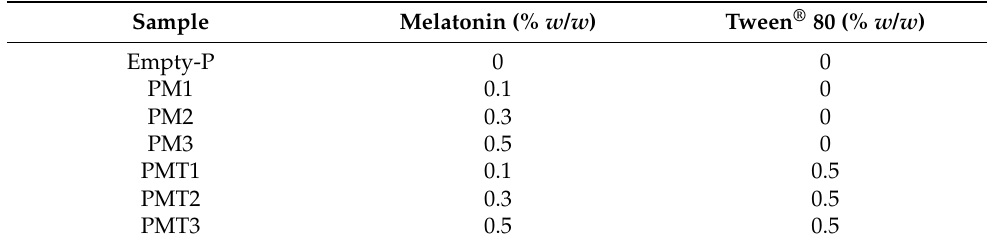
Table 2. Composition of PVA-based nanofiber samples.